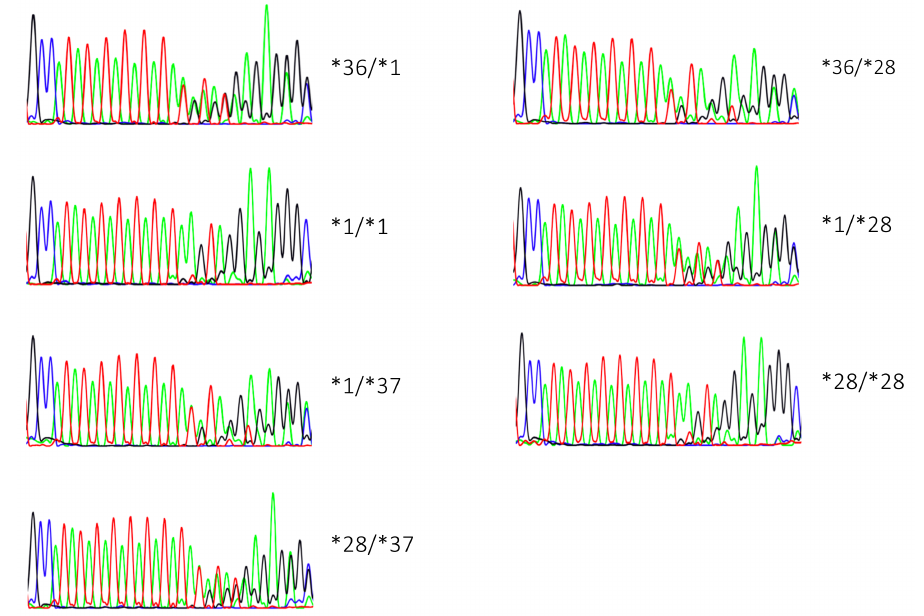
Figure 2. Representative electropherograms for each unique